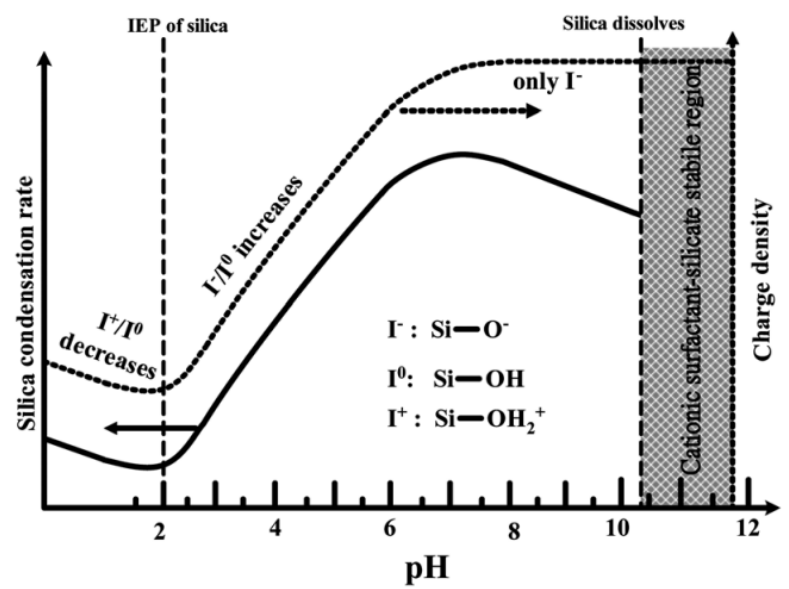
Figure 6. Effect of pH on the silica condensation rate and silica surface charge properties [46]. Copyright © 2022, Royal Society of Chemistry.